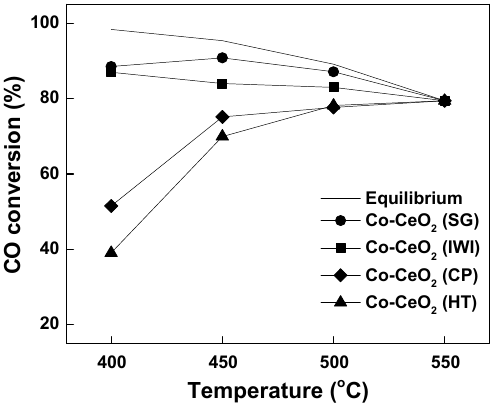
Figure 5. CO conversion with reaction temperature over Co–CeO 2 catalysts prepared by different synthetic methods (H 2 O / (CH 4 + CO + CO 2 ) = 2.0; GHSV = 143,000 h − 1 ).